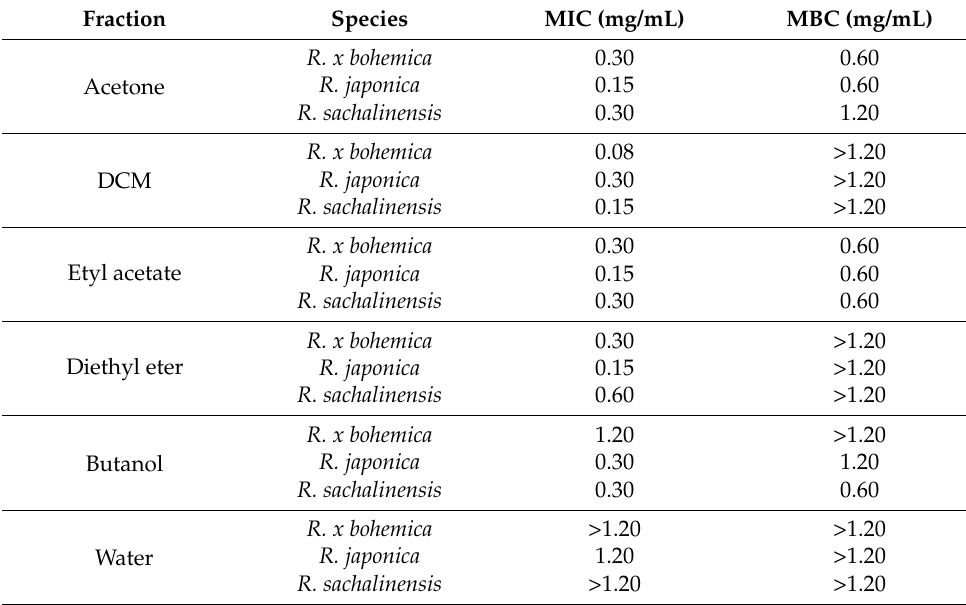
Table 5. MIC and MBC values for all analyzed